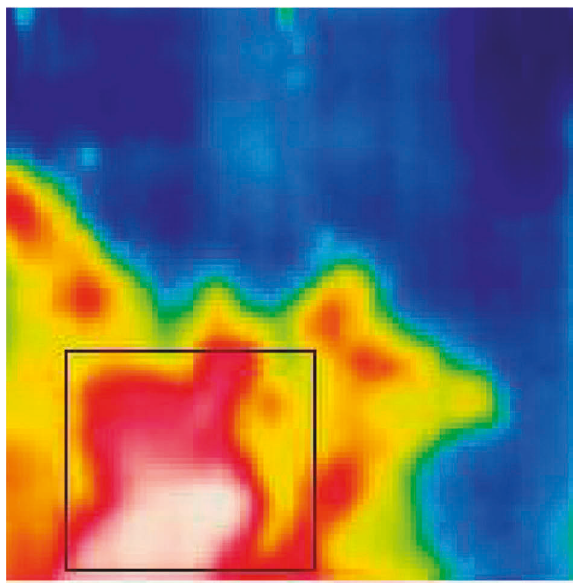
Figure 3: Hotspot location in the solar panel.